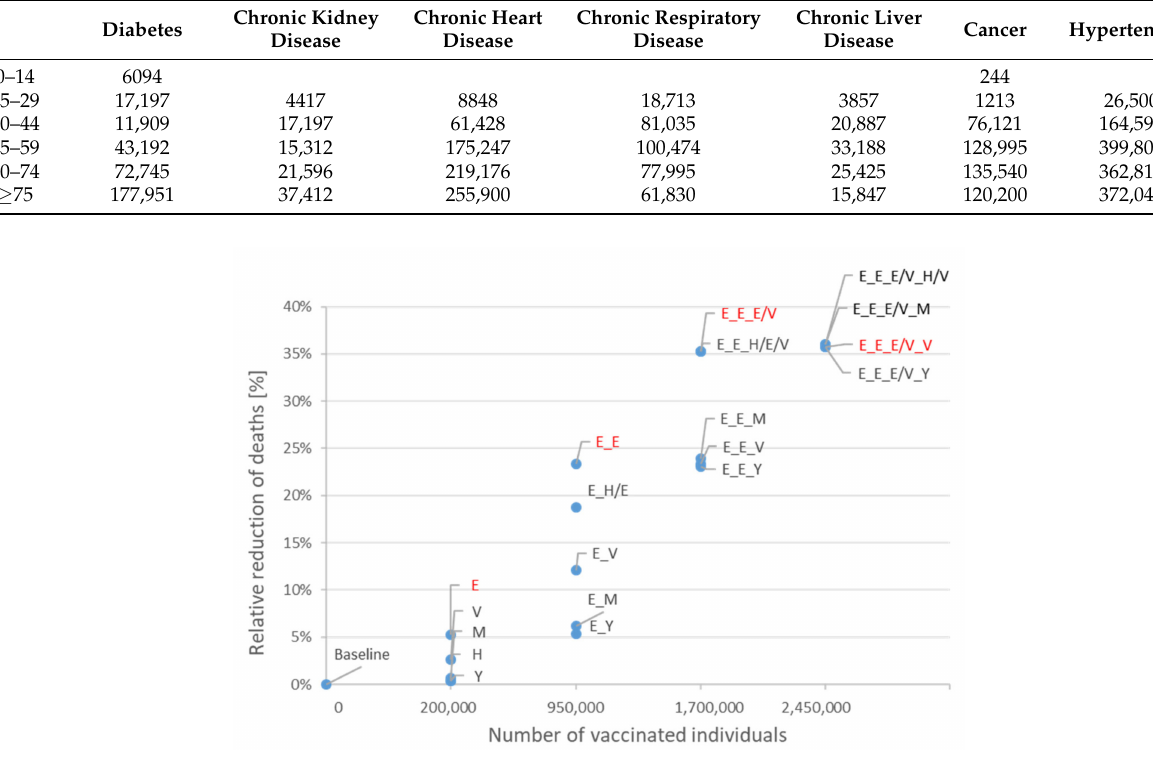
Figure A1. Cumulative relative reduction of deaths for each stepwise optimization step for a vaccine inducing non-sterilizing immunity in comparison to no vaccination (maximizing relative reduction in deaths). E—elderly ( ≥ 65 years); H—healthcare workers; M- middle-aged persons (45–64